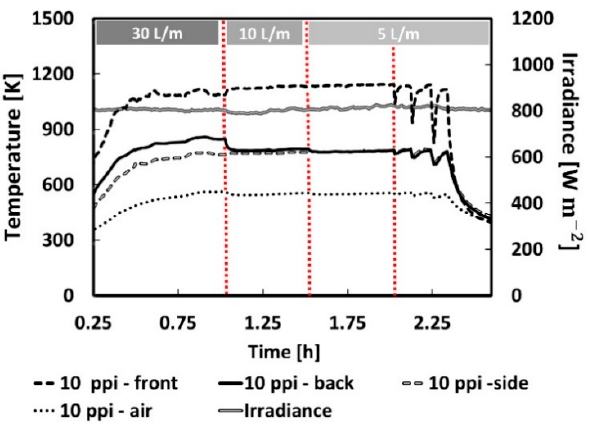
Figure 5. Temperature data for 10 PPI absorber obtained throughout the test. Values were averaged over the sensors located in the absorber body.